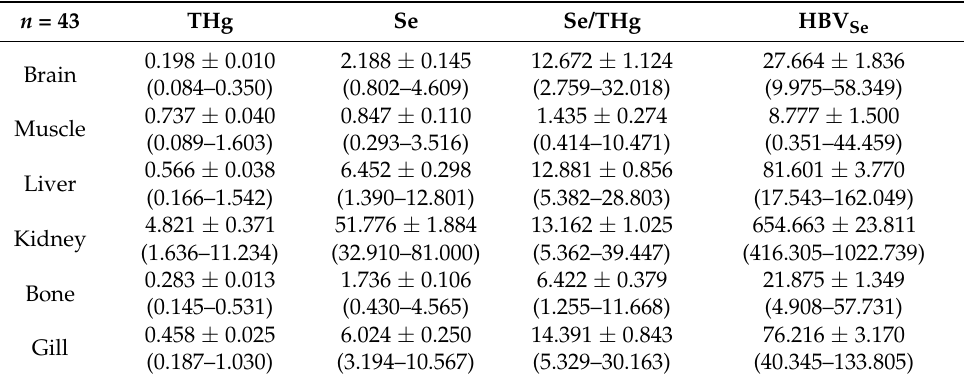
Table 1. Concentration of THg and Se ( µ g g − 1 , ww), Se/THg concentration ratio and HBV Se in tissues of ABFT. Data: mean ± standard error, minimum-maximum.